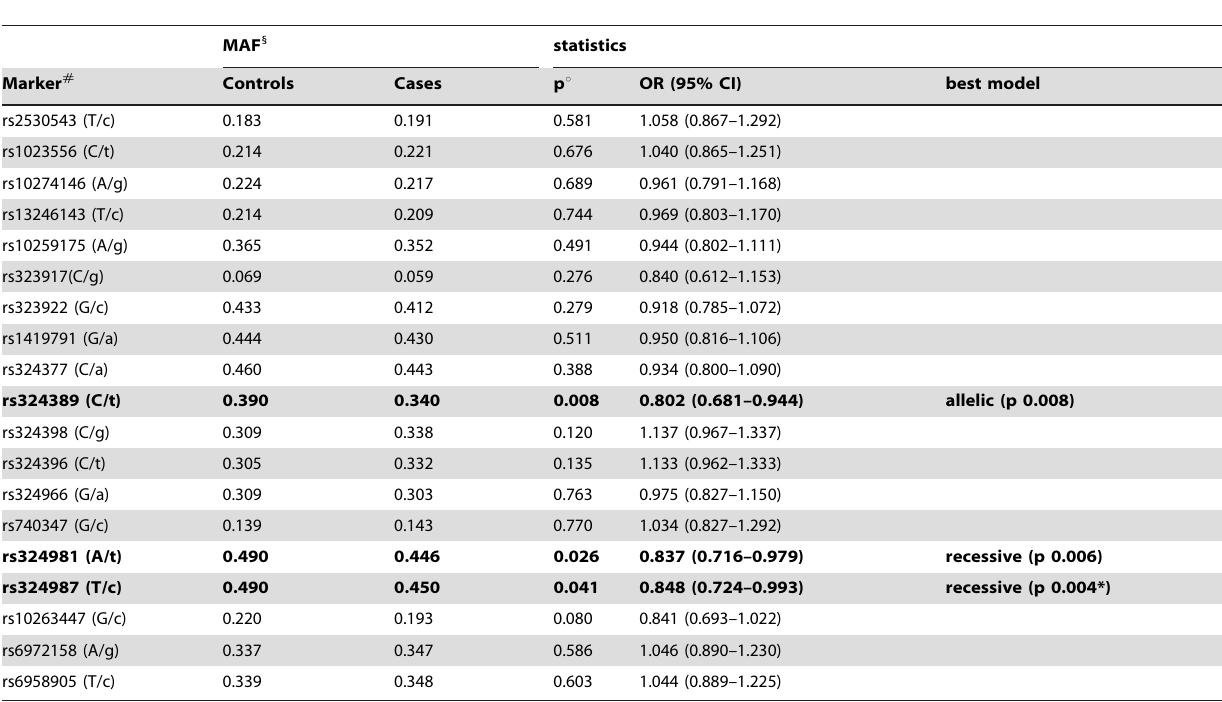
Table 1. Association between NPSR1 SNPs and rheumatoid arthritis in ACPA-negative patients vs controls.